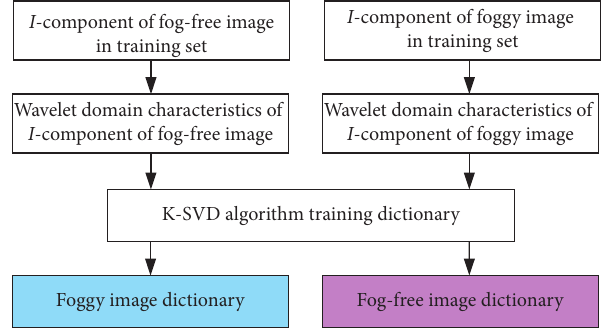
Figure 4: Dictionary training